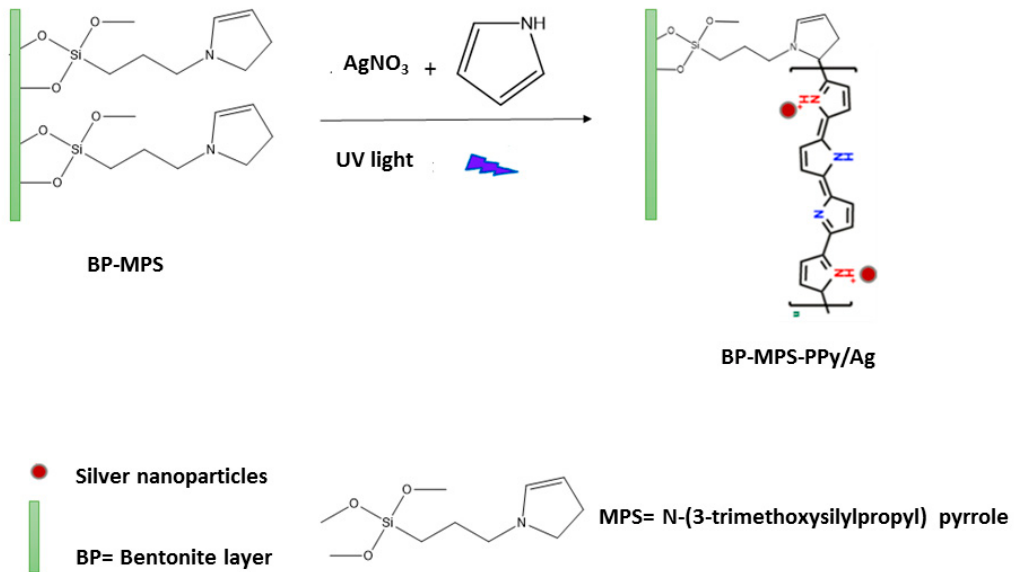
Figure 1. Surface treatment of purified Bentonite (BP) by N-(3-trimethoxysilylpropyl) pyrrole coupling agent followed by photopolymerization of polypyrrole (PPy) / silver (Ag).